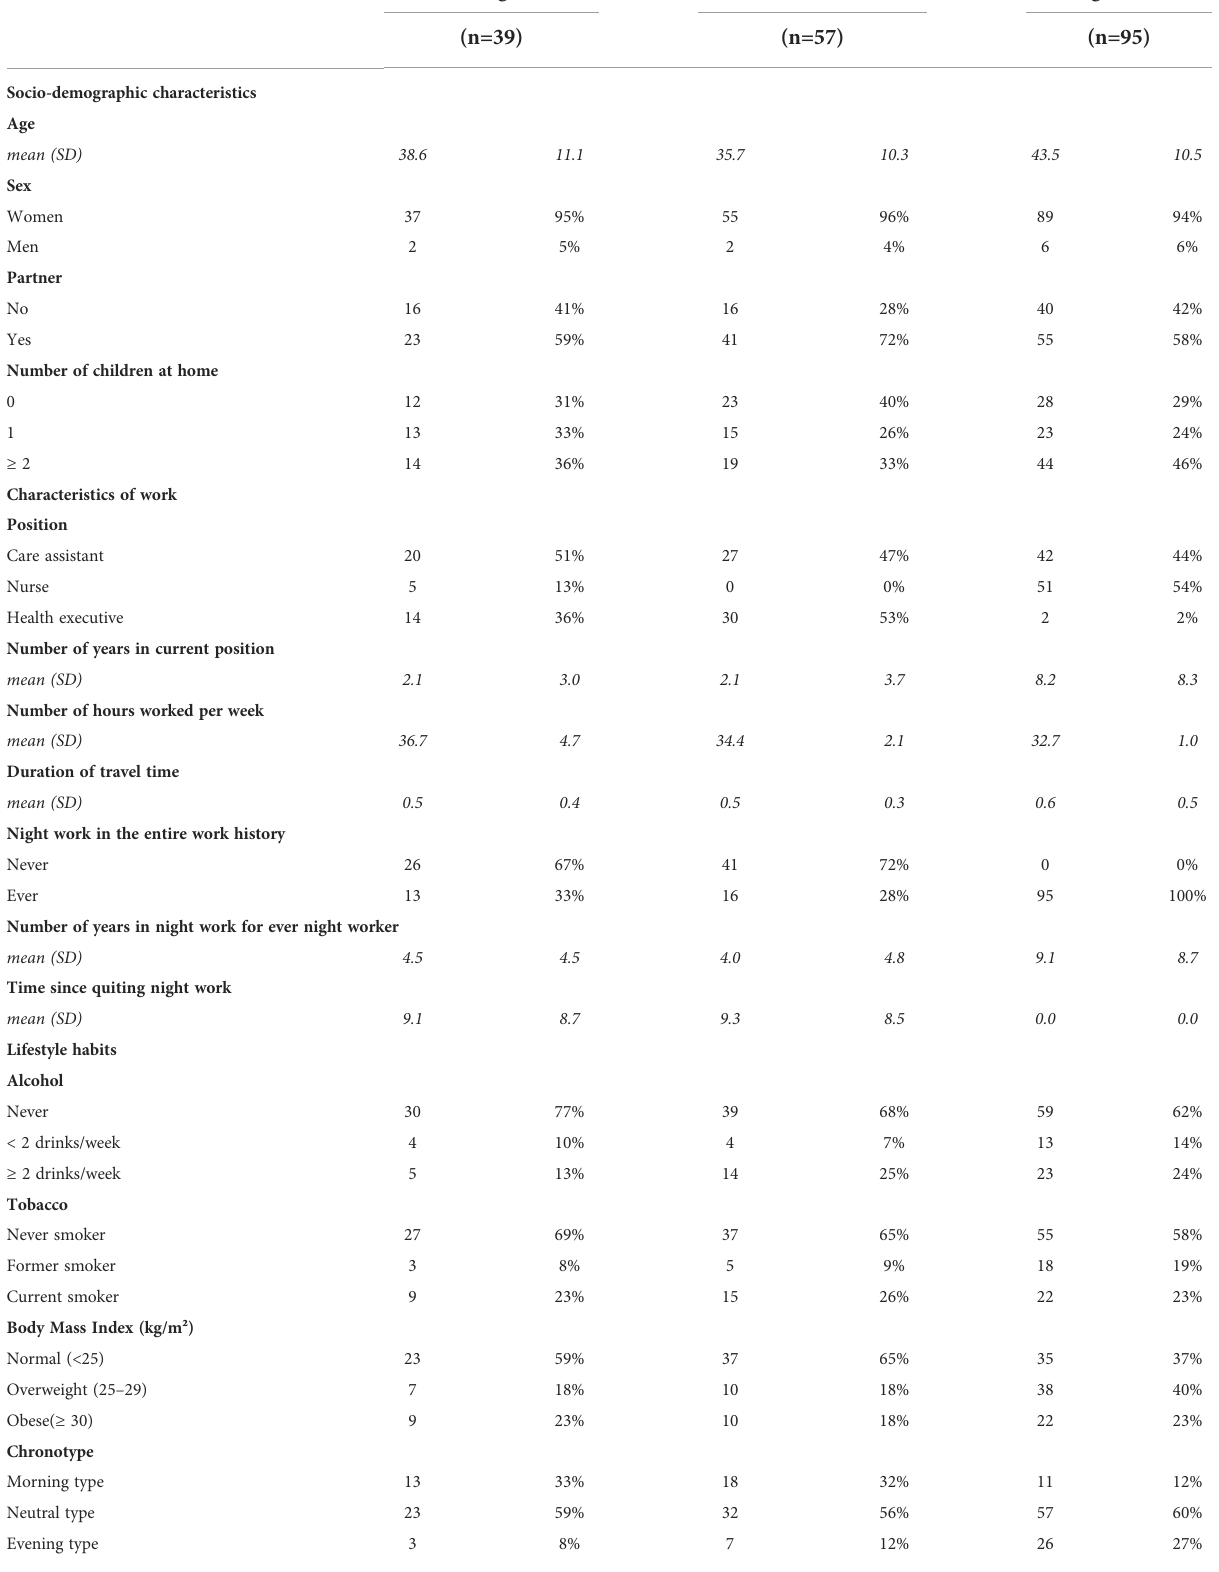
TABLE 1 Selected characteristics of hospital workers by type of work